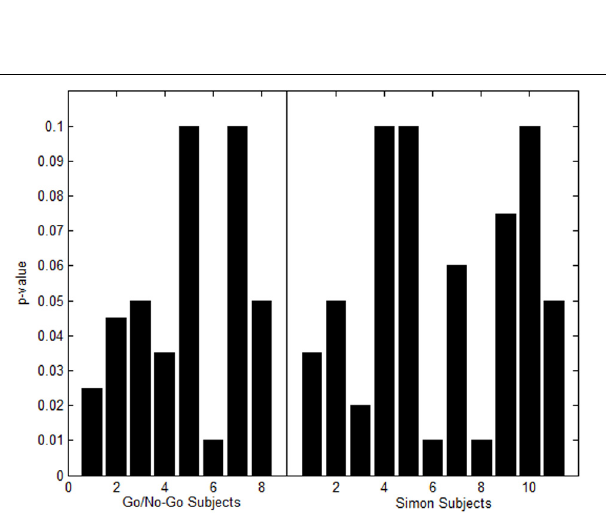
FIGURE 6 | The percentage of population belonging to each cluster for varying values of k, using all three methods (EM-sub, Mean-sub, and Zero-sub). This is shown using VB for parameter estimation.